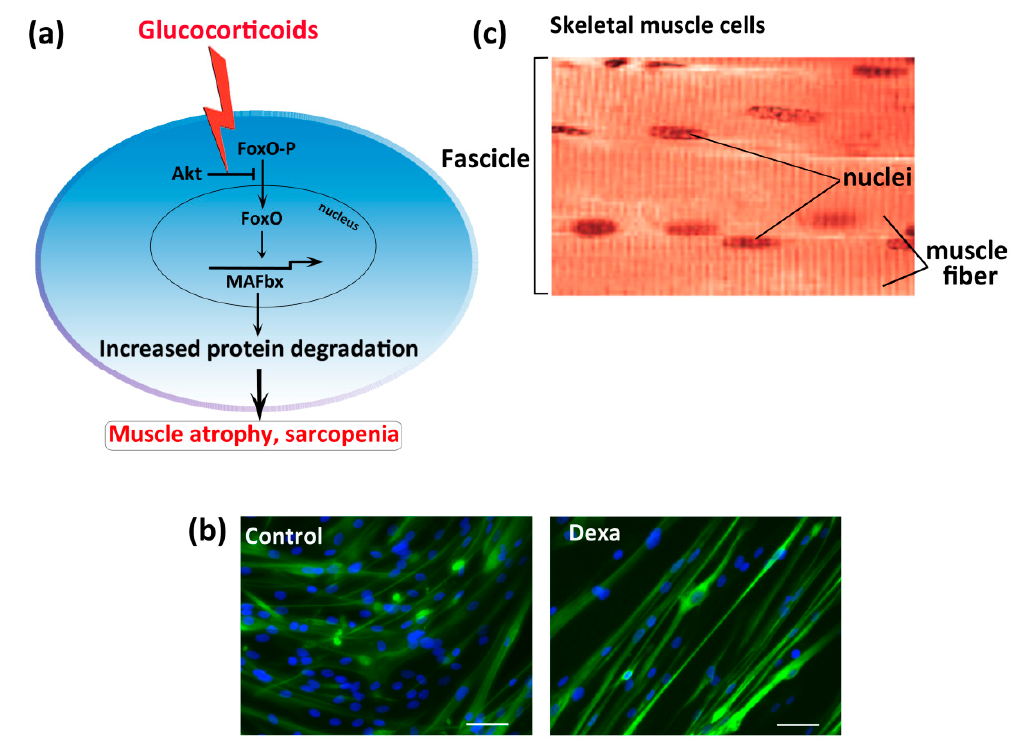
Figure 1. Sarcopenia induced by glucocorticoid-treated skeletal muscle cells in vitro. ( a ) Protein kinase B (Akt) causes phosphorylation and nuclear exclusion of Forkhead box protein O (FoxO) family, which suppresses atrogene (muscle atrophy F-box, MAFbx) expression and proteolysis. Dexamethasone prevents Akt-mediated phosphorylation of FoxO (FoxO-P), inducing its transfer to the nucleus and the consequent MAFbx upregulation and protein degradation. ( b ) The skeletal muscle structure. ( c ) Representative images of human myotube after dexamethasone (Dexa) treatment (50 µ M for 48 h), showing fluorescence double labeling, using an anti-myosin heavy chain-2 antibody (green), and Hoechst (nuclei in blue). Scale bar = 100 µ